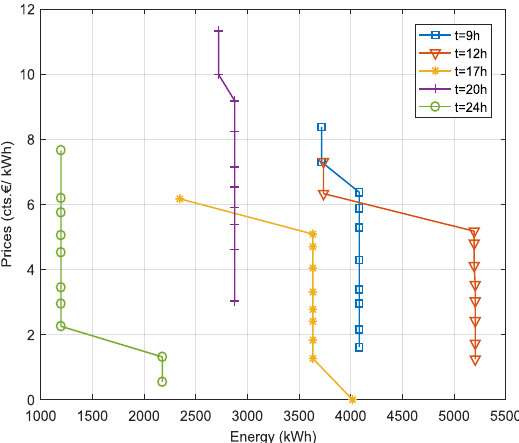
Figure 4. Optimal bidding curves to buy energy in the day-ahead market.